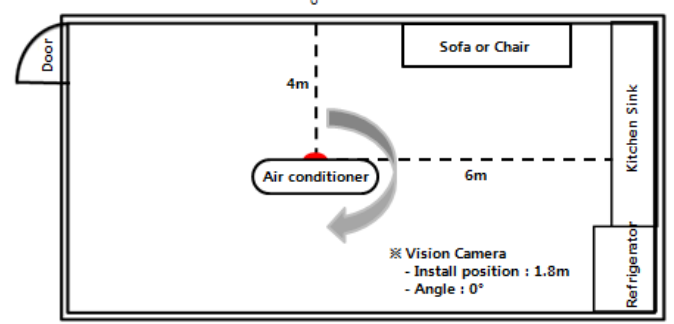
Figure 15. Experimental Environmental